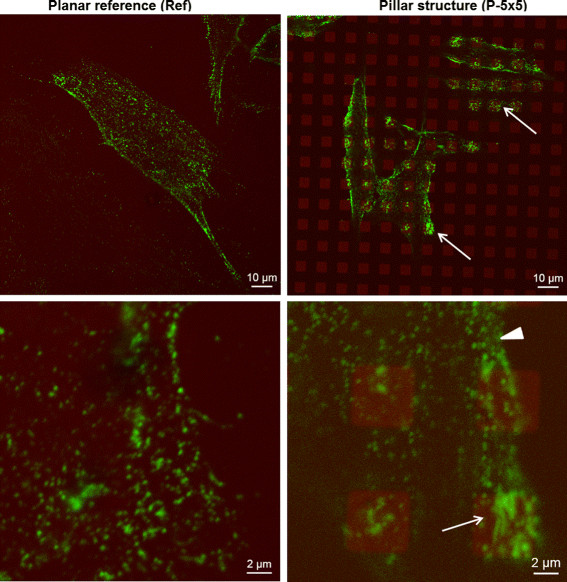
Activated β 1 integrin, detected by 9EG7, in MG-63 osteoblasts on micro-pillars. On the planar surface (left) activated β 1 integrins are homogeneously distributed, whereas on the micro-pillared surface (right) activated β 1 integrins are partly clustered on top of the pillars (arrows). Note that activated β 1 integrins are not clustered solely on pillars but formed also aggregates in parts in between the pillars (arrowhead). Confocal microscopy (LSM 780, Carl Zeiss, bars = 10 μm upper row, 2 μm lower row).